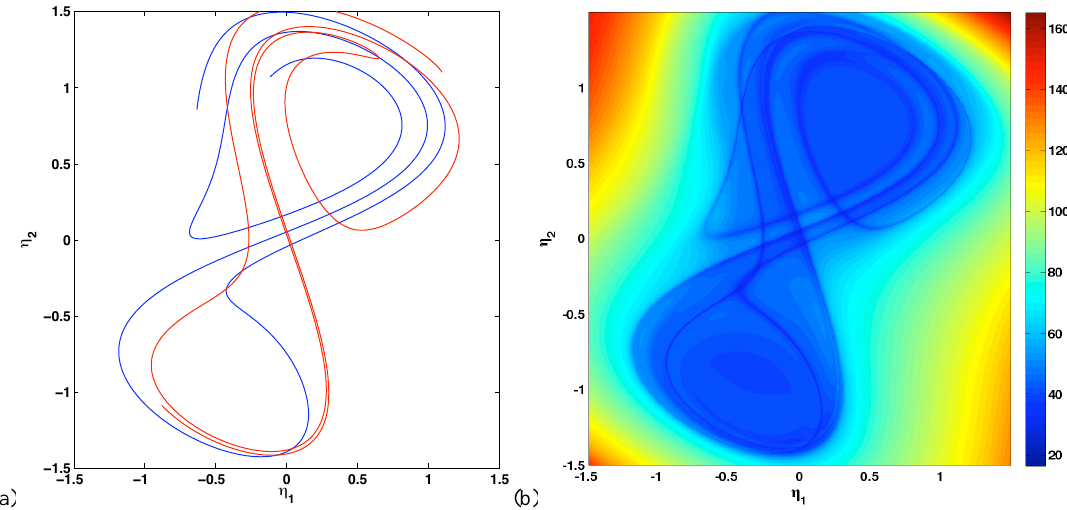
Fig. 17. (a) Invariant manifolds for the rotating Duffing equation for ω = 2 and t = 1; (b) contour plot of descriptor M for F = || v || with τ = 10 at the same ω and t